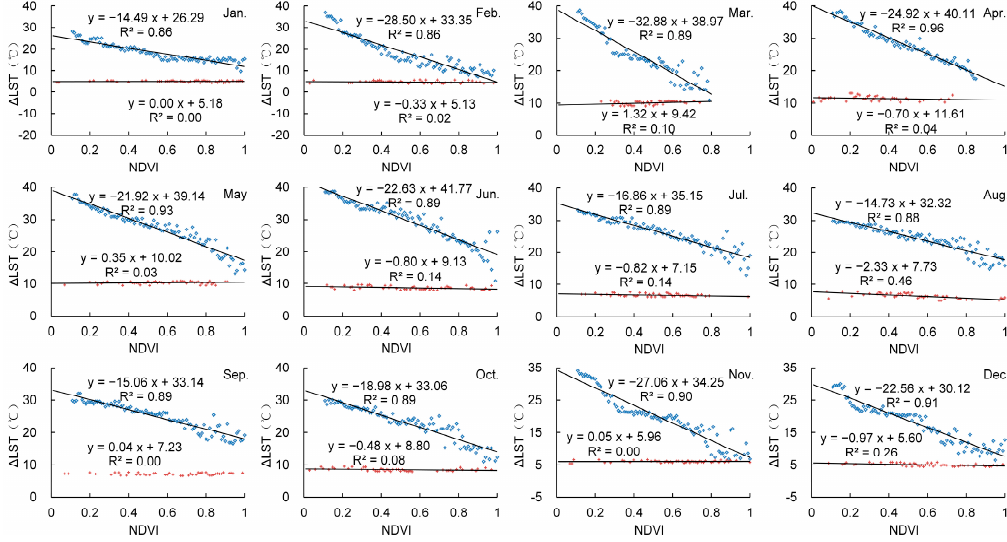
Figure 6. The improved dry (blue)/wet edges (red) and their fitting equations in 2005.